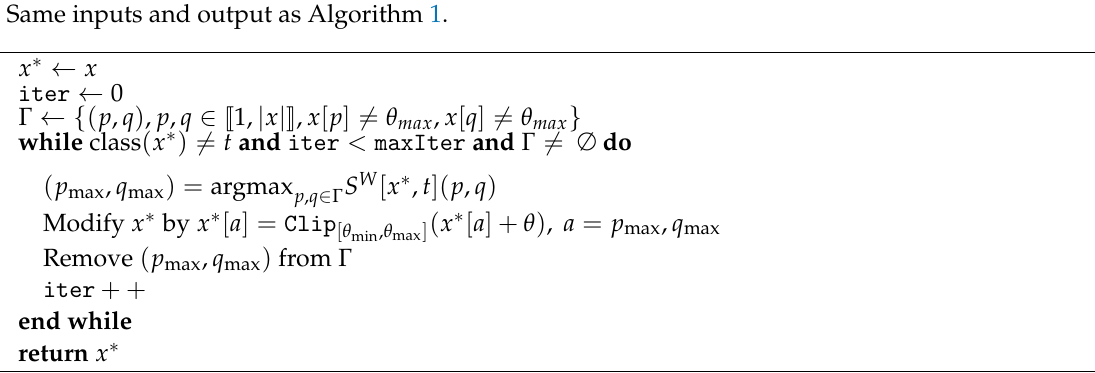
Algorithm 2 Generating adversarial samples by WJSMA: version 2. Same inputs and output as Algorithm